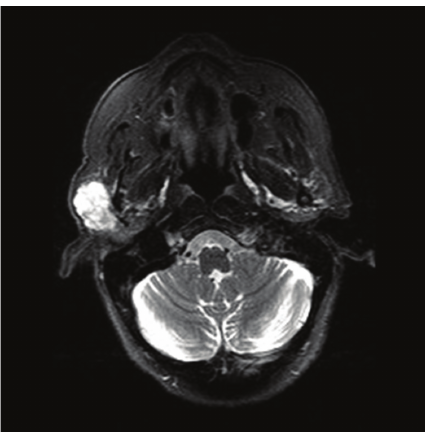
Figure 1: MRI demonstrating tumour in the right parotid gland.